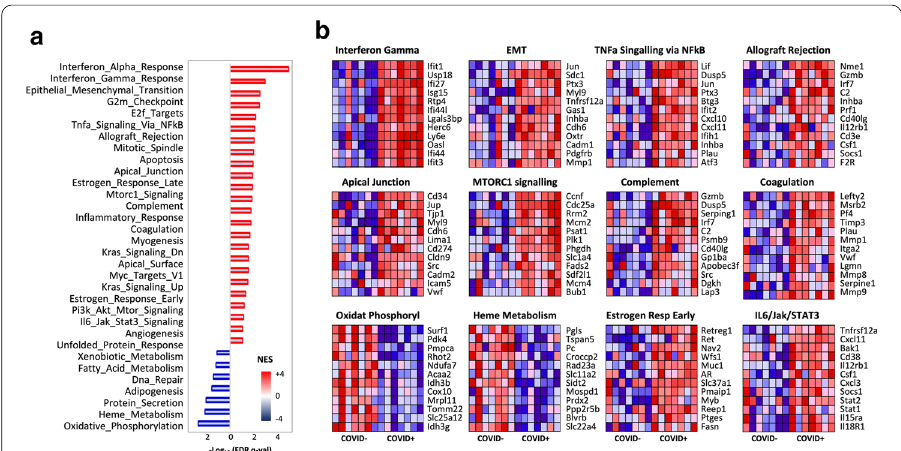
Fig. 4 Gene set enrichment analysis of transcriptional differences in circulating leukocytes from COVID19 and COVID19 critically ill patients. a Histogram of Hallmark gene set enrichment analysis. A total + − of 26/50 gene sets were positively enriched in the phenotype COVID positive ( ) and 7/50 gene sets showed + positive enrichment for the COVID negative ( ) phenotype. Differentially regulated gene sets were ranked by − normalized enrichment score (NES) and plotted against the –log 10 of the false discovery rate (FDR q value). b Heat maps of the top 12 gene sets in the ranking list in a . Red indicates positive enrichment and blue indicates negative enrichment of gene